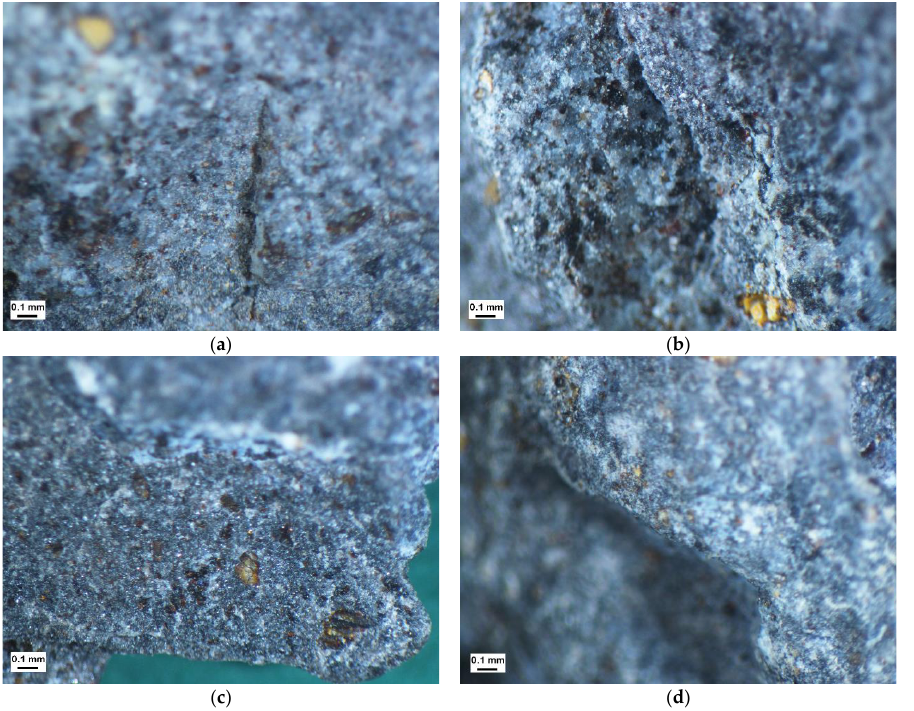
Figure A1. Characteristics of cracks in samples after crushing in jaw crusher (feed—original sample): ( a ) Basalt aggregate 1, non-flaky grains, +8 mm; ( b ) Basalt aggregate 1, non-flaky grains, +16 mm; ( c ) Basalt aggregate 1, flaky grains, +8 mm; ( d ) Basalt aggregate 1, flaky grains, +16 mm.